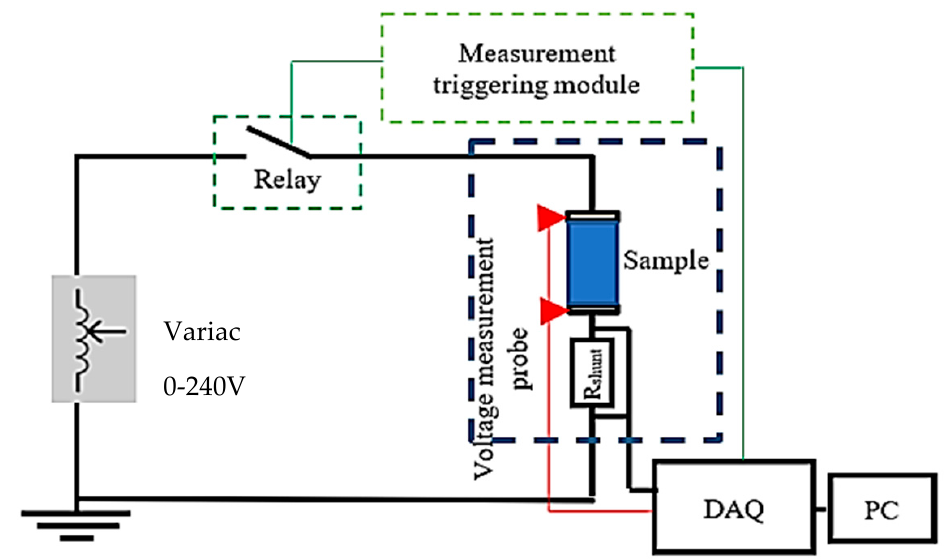
Figure 11. Low- and high-voltage test setup diagram.